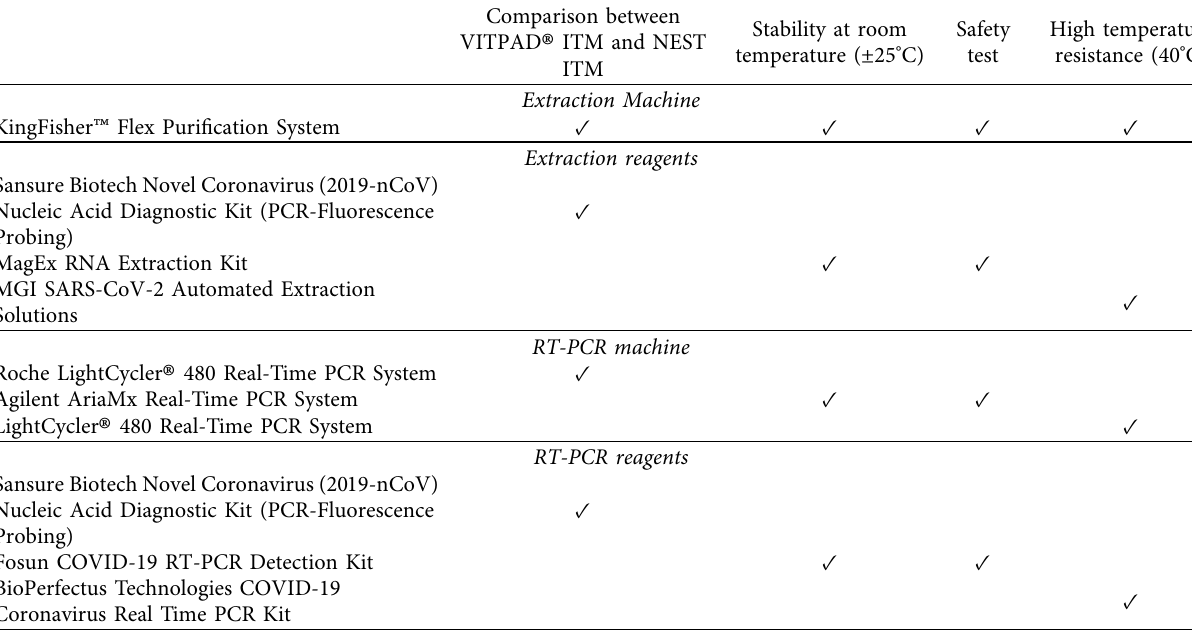
Table 1: Reagents preparation. Comparison